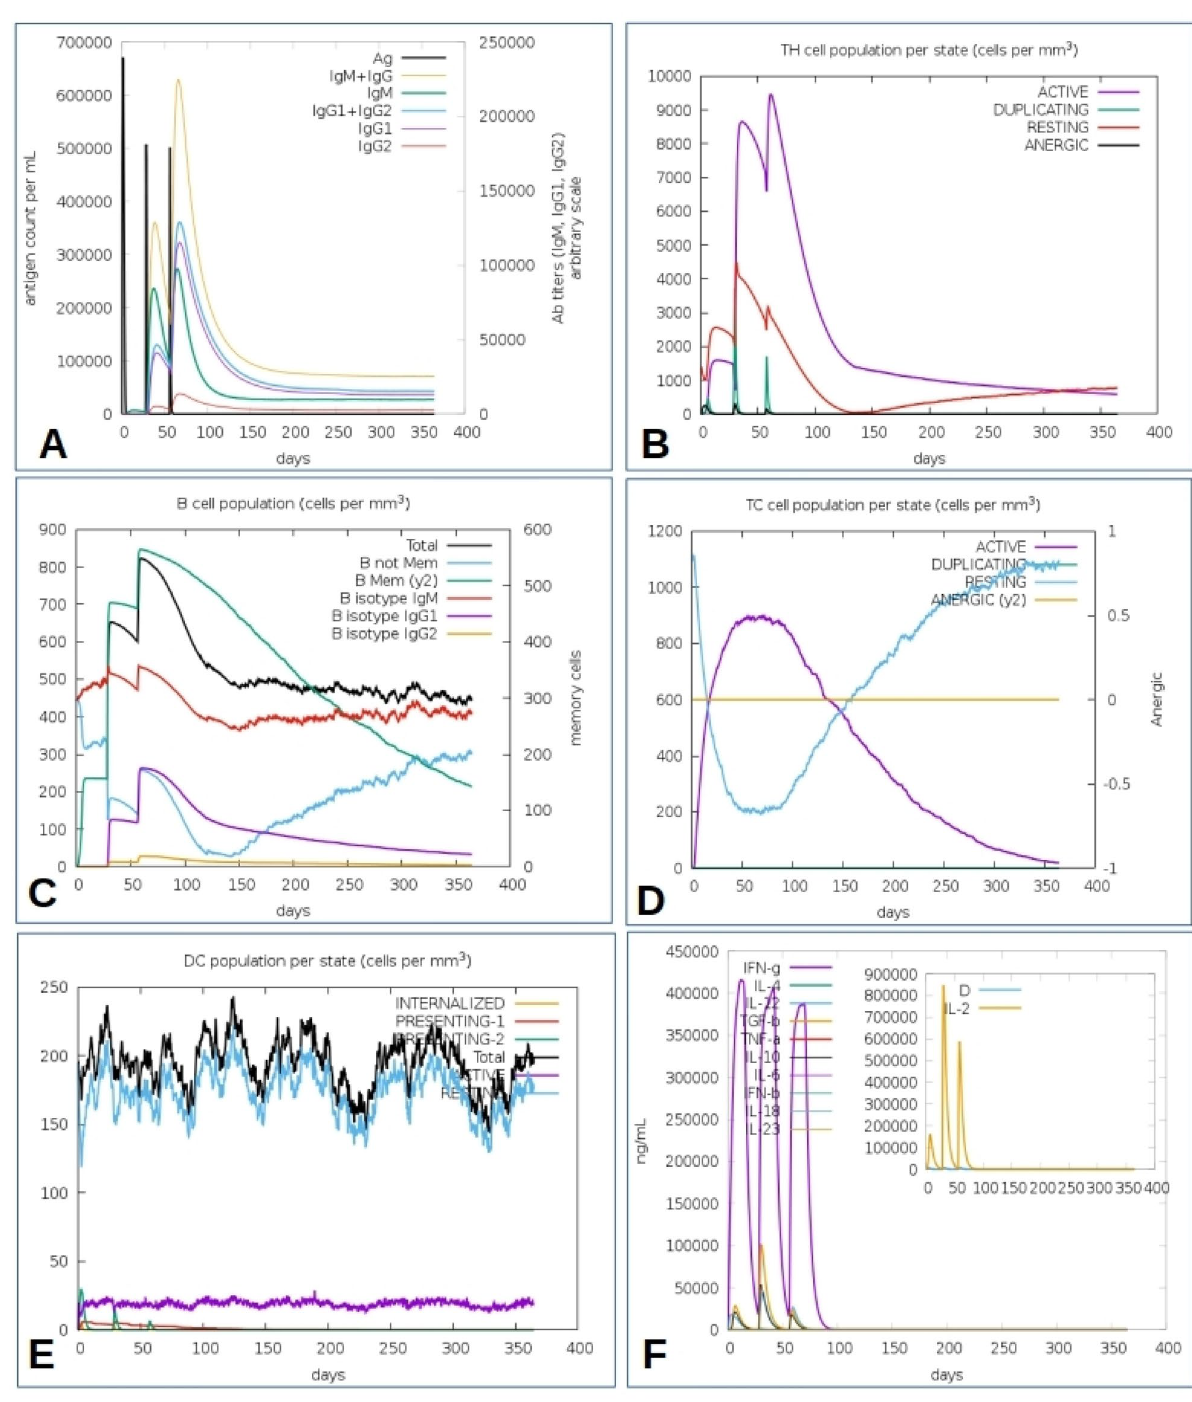
Figure 7. C-ImmSim reveals the immune profile of the CCHFV chimeric vaccine antigen. ( A ) Immunoglobulin production after immunization with sub-type indicated as coloured peaks, ( B ) Evolution of CD4 T-helper lymphocytes count per entity-state, i.e., active, resting, anergic, and duplicating. ( C ) Population of B lymphocytes after three injections with the total count, memory cells, and IgM, IgG1, and IgG2 isotypes, ( D ) CD8 T-cytotoxic lymphocytes count after immunization, ( E ) Dendritic cell population per state which presents antigenic peptides on both MHC class-I and class-II molecules, and ( F ) Concentration of cytokines and interleukins after injection with Simpson